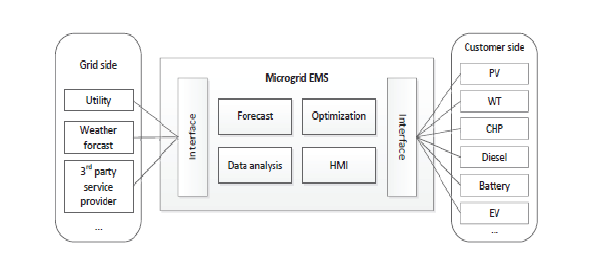
Figure 1. Microgrid Electric Management